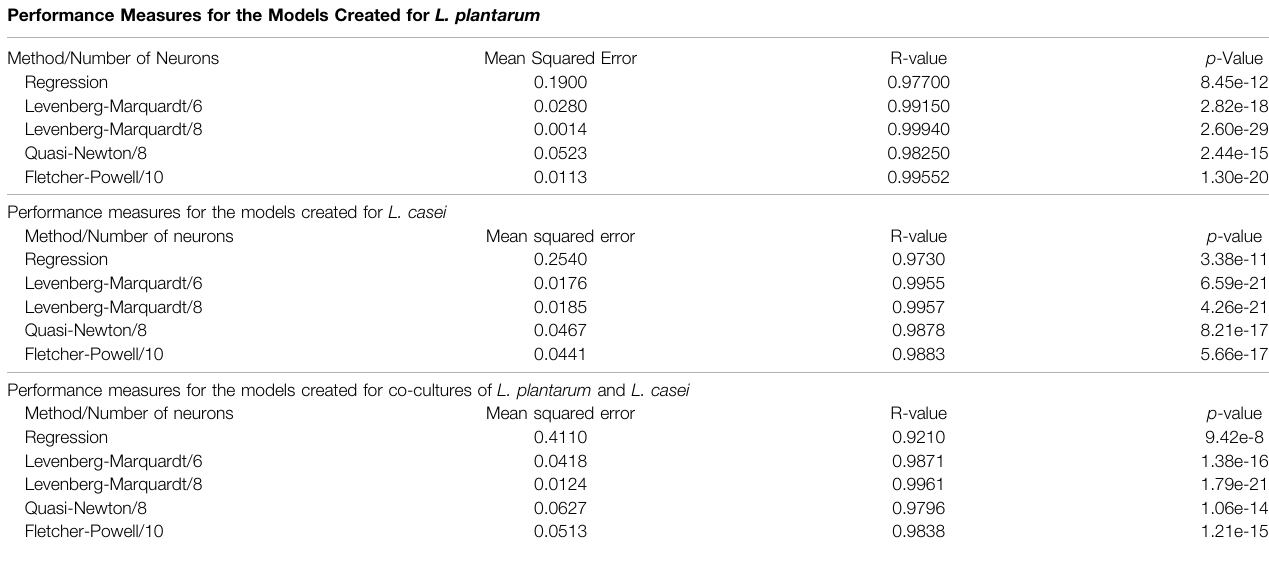
TABLE 3 | Performance measures for the models created. Performance Measures for the Models Created for L. plantarum Method/Number of